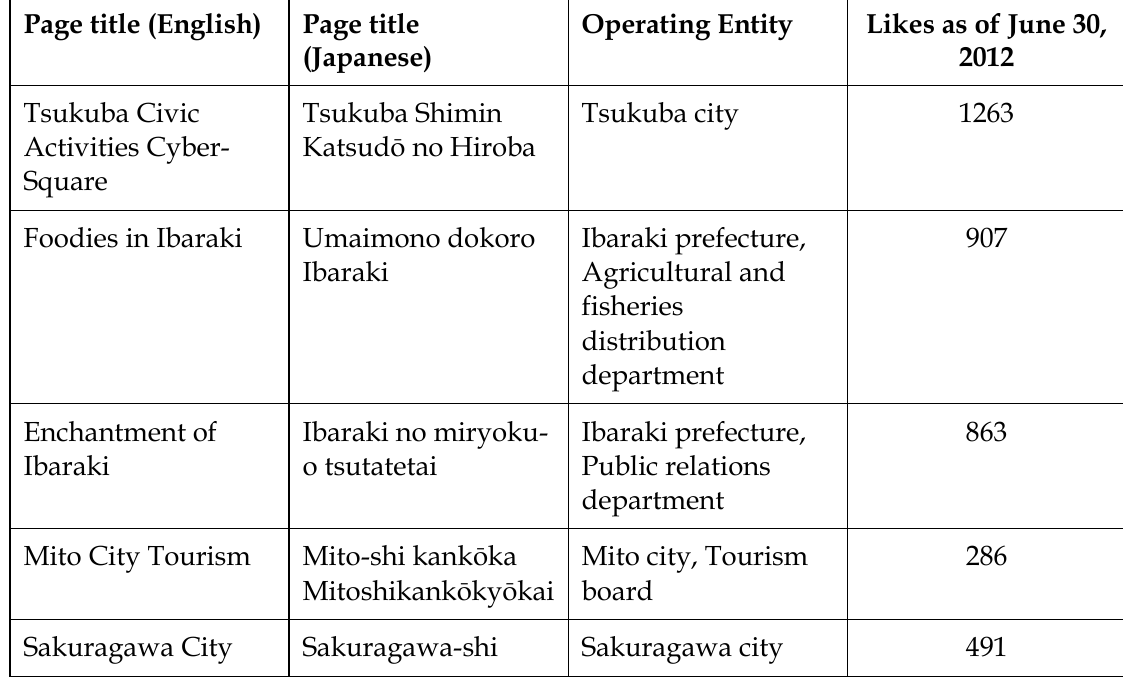
Table 1: Top Five Facebook Sites Originating in Ibaraki Prefecture (January to June